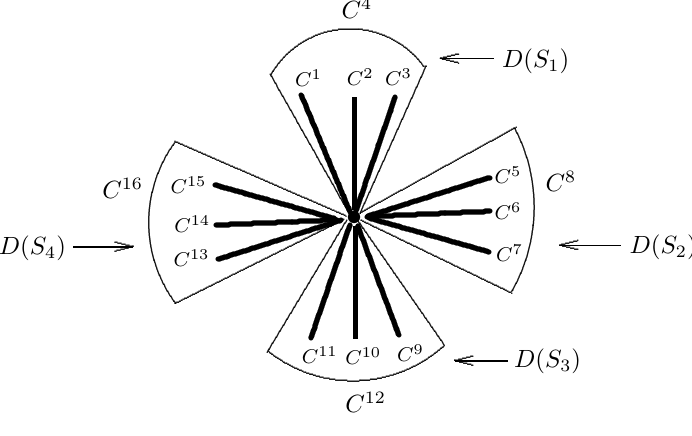
Figure 12: A planar embedding of a